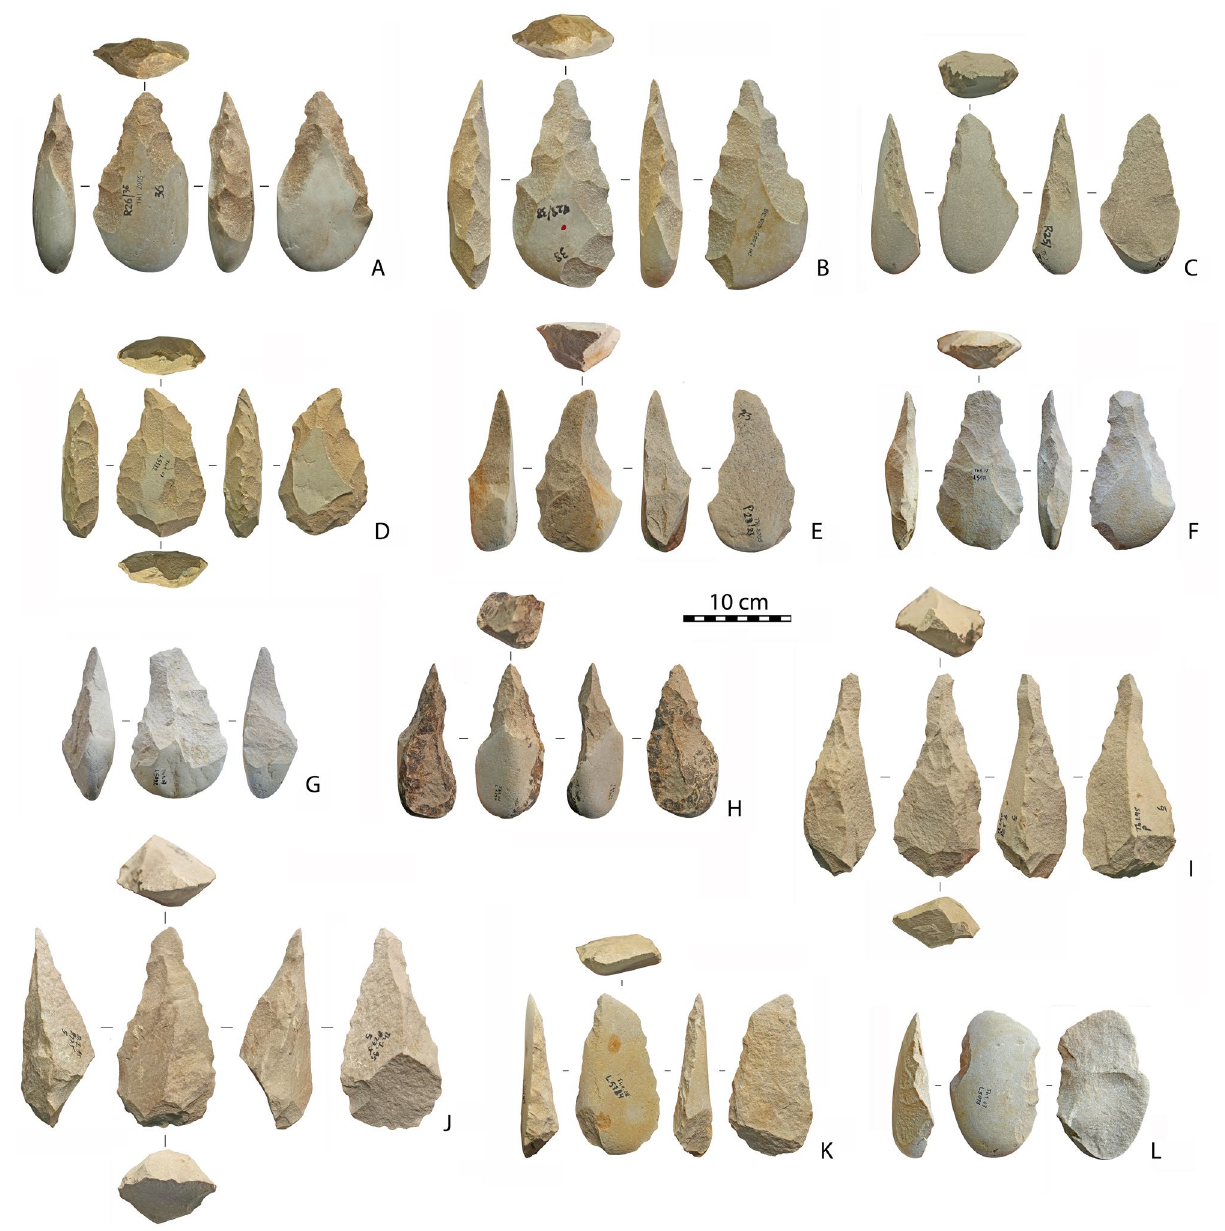
Figure 4. LCTs. ( A,B ) pointed handaxes on cobble; ( C ) pointed handaxe on entame flake; ( D,E ) pointed handaxes on cobble with a skewed point; ( F,G ) beveled handaxes; ( H ) pick on cobble; ( I,J ) picks on core edge flake from block; ( K,L ) cleavers on entame flake. This figure was generated on the basis of photos made by R. Gallotti with Adobe Photoshop CC version 2015-1, 20151114.r301 X64. Copyright 1990 2015 Adobe Systems Incorporated and its licensors. All rights